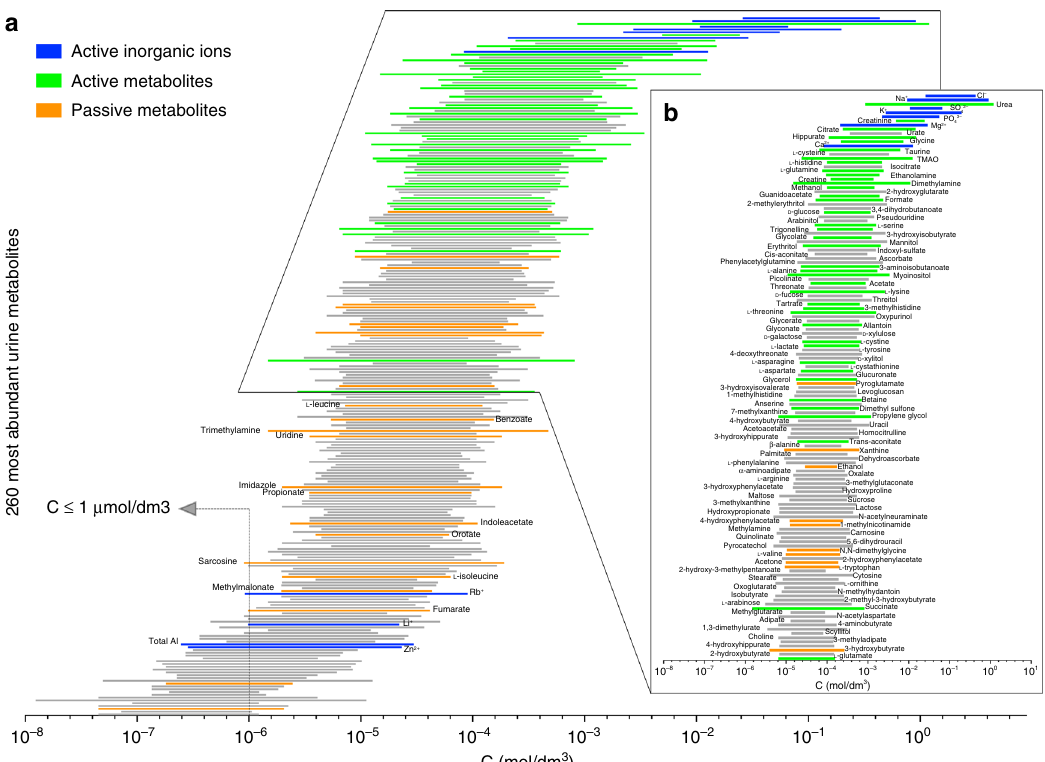
Fig. 1 Most abundant urine metabolites and their concentration ranges in physiological conditions. Concentration ranges of the 260 most abundant metabolites in urine as determined by liquid chromatography coupled with mass spectrometry (LC-MS), NMR spectroscopy, gas chromatography with mass spectrometry (GC-MS), inductively coupled plasma mass spectrometry (ICP-MS), and high-performance liquid chromatography (HPLC) 1 . a Metabolites are sorted according to their mean absolute concentration values in urine. In the literature, urine metabolite concentrations are reported relative to creatinine 1 . Consequently, the absolute values were calculated by multiplying the reported minimum and maximum relative concentration of each metabolite by the minimum and maximum of creatinine, respectively. In this way, the reported ranges extend somewhat more with respect to the physiological ranges. Green bars and blue bars indicate the active metabolites and the inorganic ions (respectively) used to prepare the mother solutions of the arti fi cial urine samples. Orange bars indicate the passive metabolites that were only spiked in the mother solutions. b Enlargement of the fi rst 136 urine metabolites, with mean concentration value > 30 μ M. Among these metabolites, we have selected 47 (green and blue bars) as a part of the active metabolites, taking into account not only their high abundance, but also their high occurrence in urine 1 . Four additional inorganic ions (rubidium, lithium, aluminum, and zinc) were included among the active metabolites because they affect the metabolite signal chemical shifts even